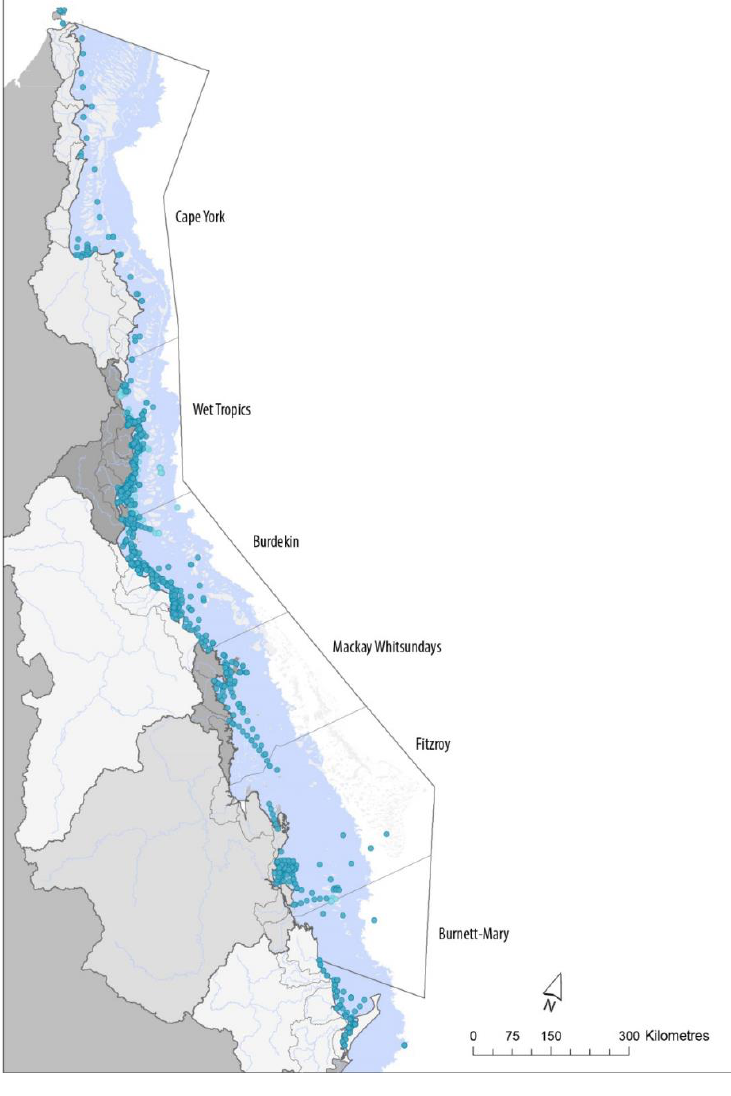
Figure 2 . Selection of wet season sites sampled in the Northern, Central, and Southern GBR under the MMP (Marine Monitoring Program) (2006–2013). For full details, http://www.gbrmpa.gov.au/managing-the-reef/how-the-reefs-managed/reef-2050-marine-